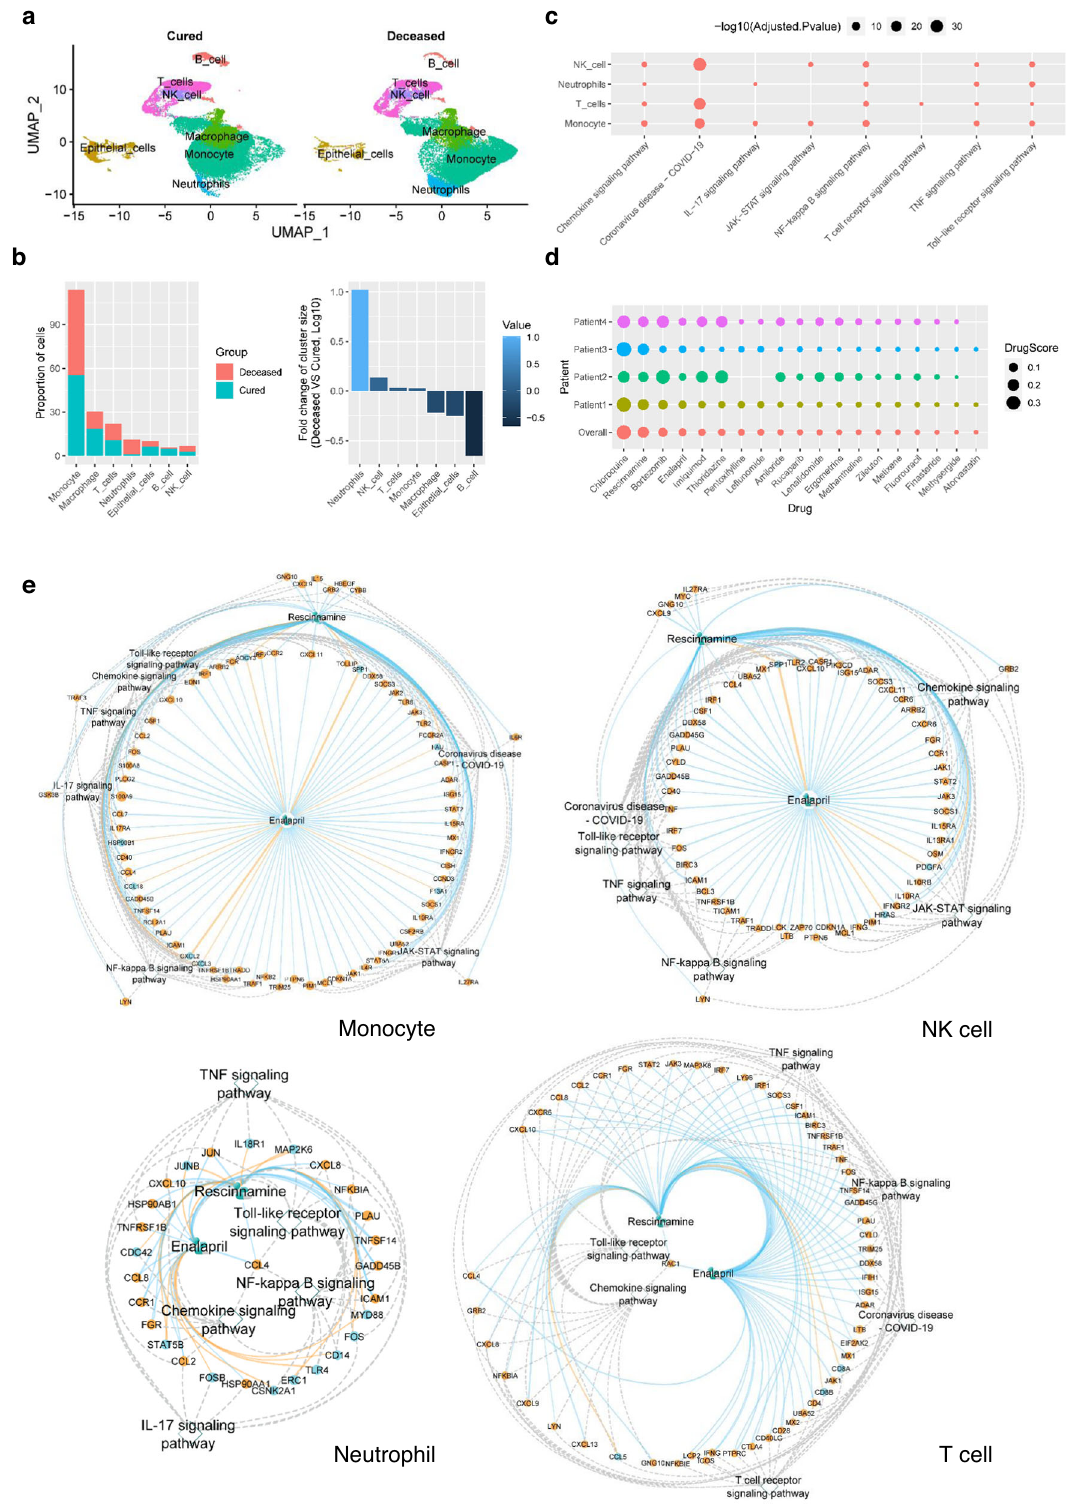
Fig. 6 | Drug repurposing for reducing mortality of severe COVID-19 patients. a Single-cell populations of bronchoalveolar immune cells in 11 cured and four deceased severe COVID-19 patients, respectively. b The proportions of cell type in (left) and log10 transformed fold changes in deceased over the cured state (right) of the single-cellpopulations in a . c Pathwayenrichmentanalysis (deceased severe vs. cured severe) for neutrophil, NK cell, T cell, and monocyte, respectively. P -valuesweredeterminedbytwo-sidedFisher ’ sexacttestandwereadjustedbyBH